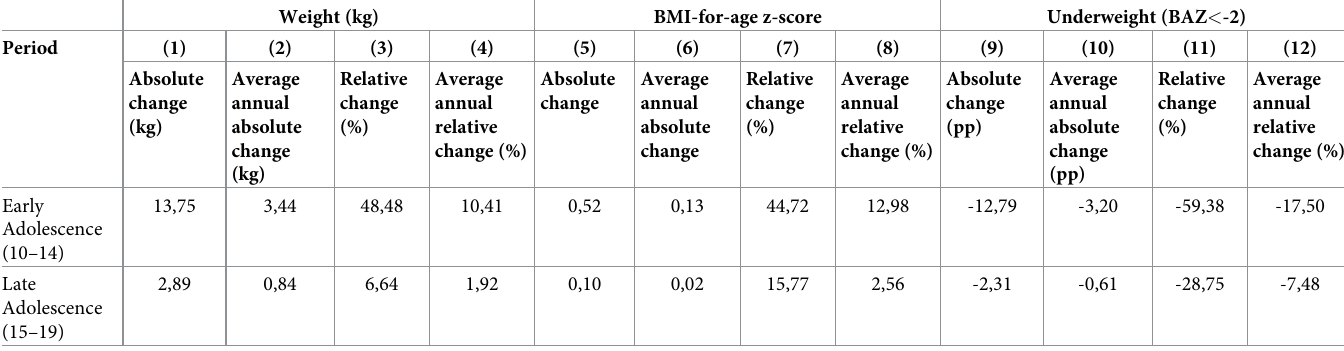
Table 2. Changes in weight, BMI-for-age z-score, and underweight during early and late adolescence. Weight (kg) BMI-for-age z-score Underweight (BAZ < -2)